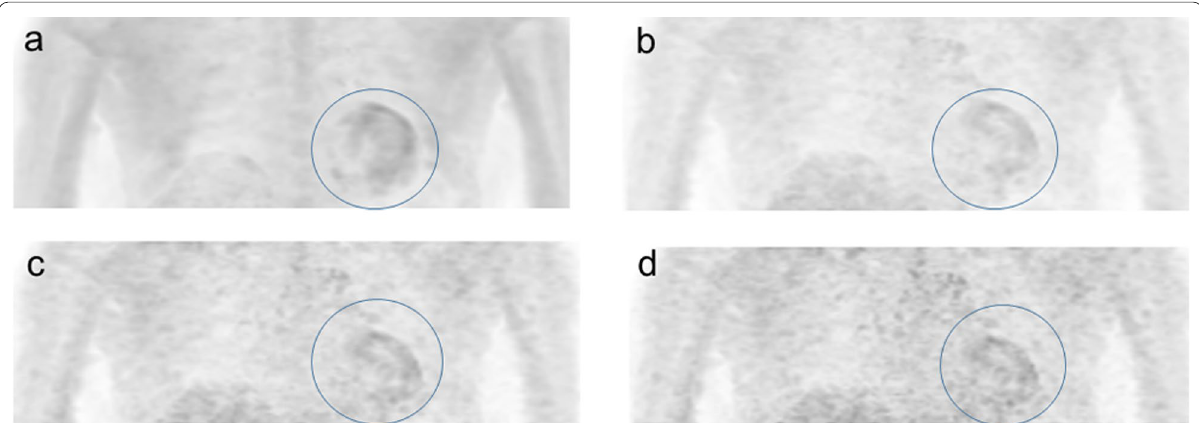
Fig. 3 A 51-year-old male patient with cardiac sarcoidosis under steroid treatment. The individual patient-based Ki image ( a ) had a visual score of 3 in the myocardium (circle). Both the Ki-1000 ( b ) and Ki-700 images ( c ) had a visual score of 2 (circles), whereas the Ki-350 image ( d ) had a visual score of 1 (circle)